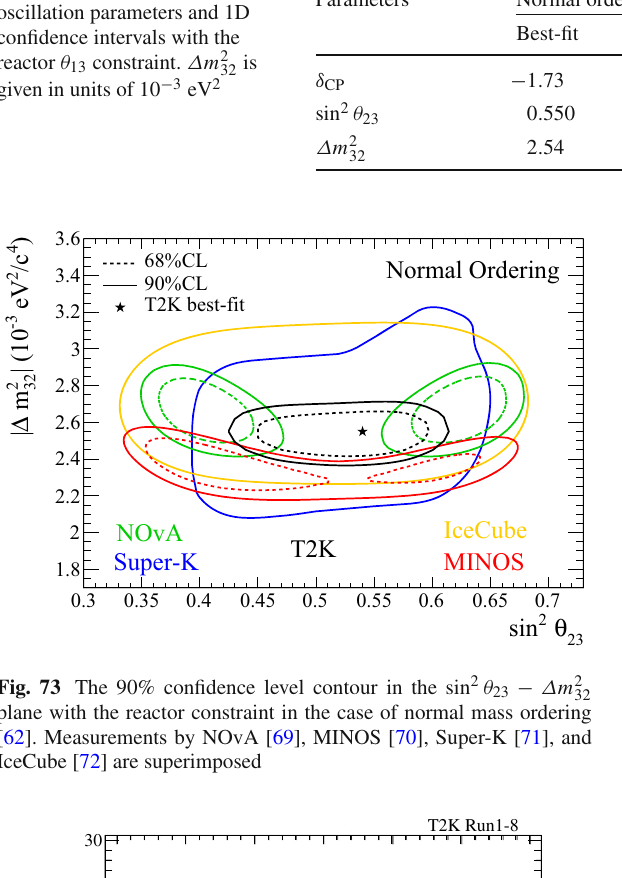
Table 18 The best fit values of oscillation parameters and 1D confidence intervals with the reactor θ 13 constraint. Δ m 2 given in units of 10 − 3 eV 2